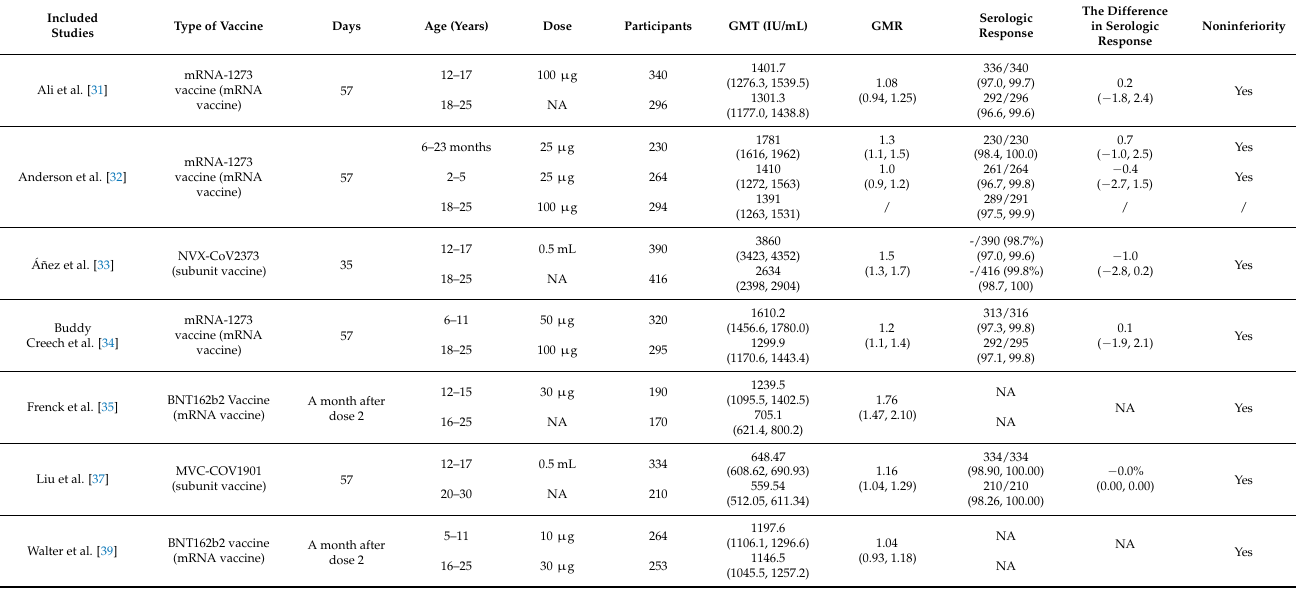
Table 8. Immunogenicity of included studies.